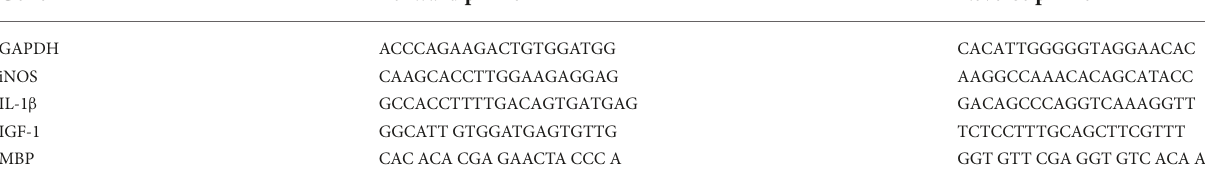
TABLE 1 PCR primers